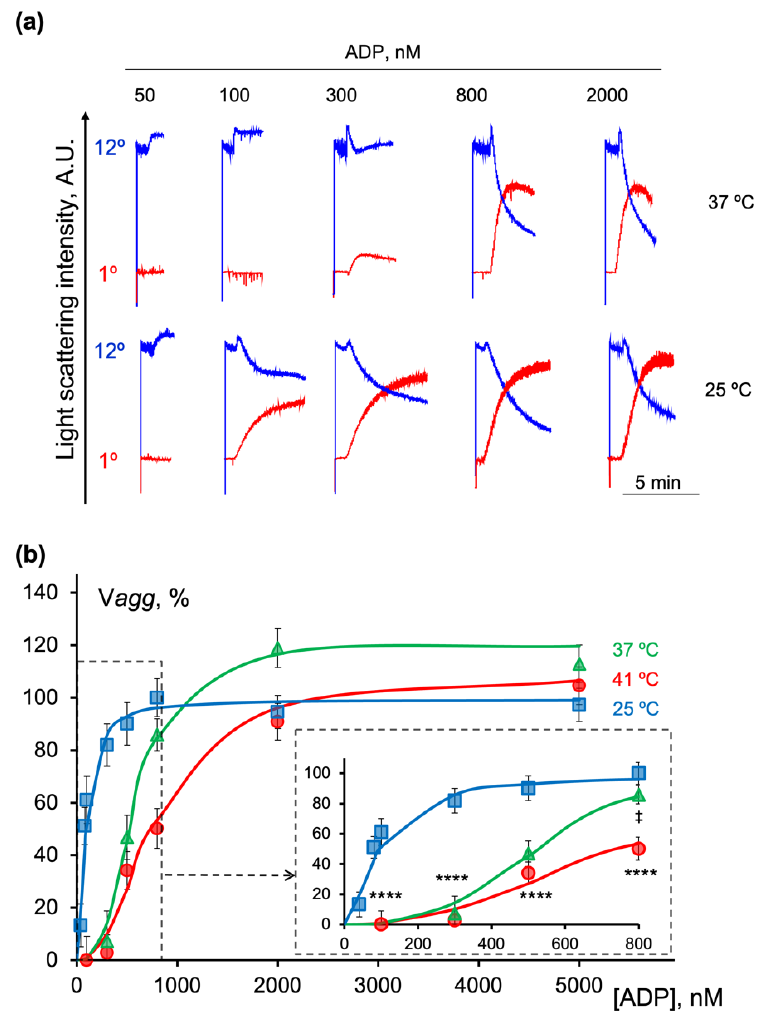
Figure 6. Initiation of platelet aggregation and its velocity were differentially regulated by temperature. PRP diluted in HEPES buffer (1 × 10 7 platelets/mL) was added to the cuvette with a continuous stirring (1200 rpm) at the indicated temperature. After 2 min of incubation, indicated concentrations of ADP were added and the LSI signal was monitored in dynamics at 1 ◦ and 12 ◦ . For better visualization, the data of LSI at 12 ◦ were multiplied by 50. ( a ) Shown are the original representative traces from four independent experiments; ( b ) the dose-response curve of aggregation velocity (V agg ) plotted against ADP concentrations. Points indicate the normalized V agg data, continuous lines represent fits of the Hill equation to the experimental data. The enlarged part of the graph of the initial steps of aggregation is shown in a separate box. Data are presented as means ± SD, two-way ANOVA, Tukey’s post-hoc; **** p < 0.0001, ‡ , p = 0.0075 compared to 25 ◦ C, n =